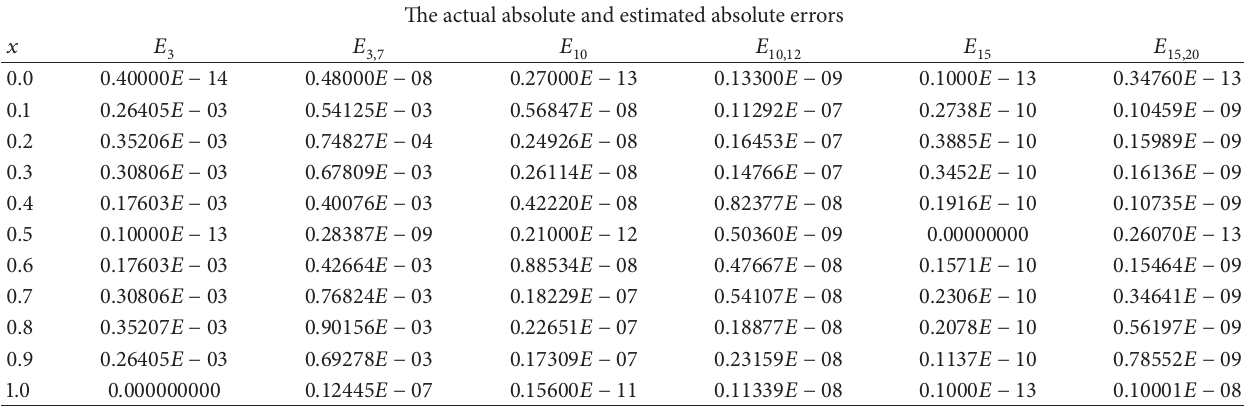
Table 2: Comparison of the actual and estimated absolute errors for 𝑁 = 3, 10, 15 and 𝑀 = 7,12, 20 of Example 4.